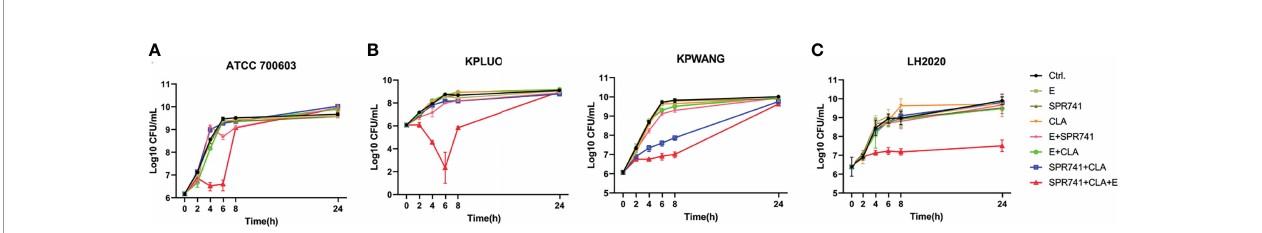
FIGURE 3 | Triple antibiotic combination exhibits bactericidal activity against XDR and PDR K. pneumoniae. Time-killing curve of monotherapy, double, and triple combination therapies based on 7 µg/mL SPR741, 5 µg/mL CLA, and 7 µg/mL E against type strain of ATCC700603 (A) , and 2 µg/mL SPR741, 2 µg/mL CLA, and 4 µg/mL E against XDR K. pneumoniae KPLUO and KPWANG (B) ; PDR K. pneumoniae LH2020 was treated with 8 µg/mL SPR741, 8 µg/mL CLA, and 16 µg/mL E; bacterial suspension was treated with 0.1% DMSO served as a control (C) . Samples were harvested, diluted, and counted at time-points of 0, 2, 4, 6, 8, and 24 h. Experiment was repeated three